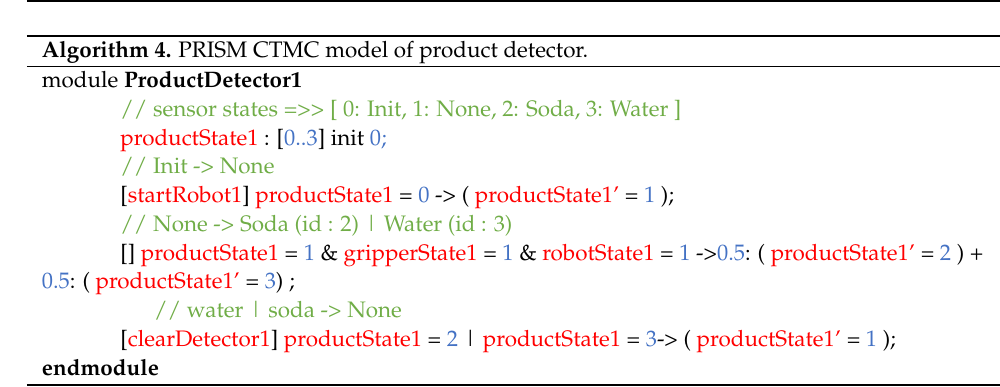
Algorithm 4. PRISM CTMC model of product detector.